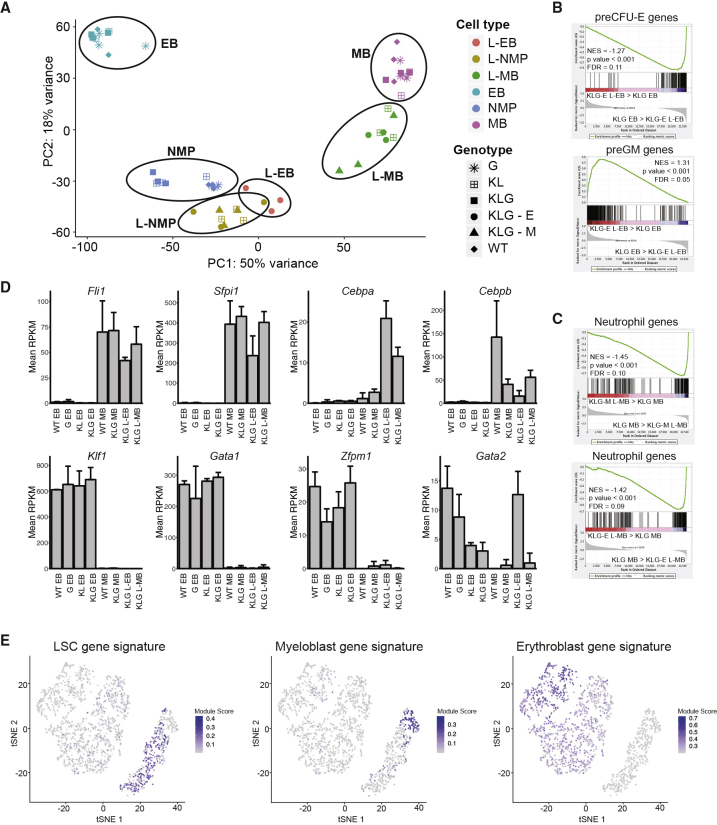
Erythroid Leukemia LICs Show Ectopic Myeloid Transcriptional Programming(A) Principal-component analysis of RNA sequencing data using the top 500 most variable genes across the entire dataset. The ovals have been drawn to encompass the populations indicated next to them, n = 3 per population.(B) GSEA of KLG-E L-EB versus KLG EB using preCFU-E (top panel) and preGM gene sets (bottom panel). Normalized enrichment score (NES), p value and false discovery rate (FDR) are indicated.(C) GSEA of KLG-M L-MB versus KLG MB (top panel) and KLG-E L-MB versus KLG MB (bottom panel) using a neutrophil differentiation-specific gene set as in (B).(D) Histograms showing expression levels of selected TF-encoding genes measured by RNA sequencing in the indicated cell populations. Values are mean reads per kilobase million (RPKM) ± SD, n = 3 per population.(E) tSNE plots of human AEL single cell showing expression of indicated signatures.See also Figure S8 and Table S4.